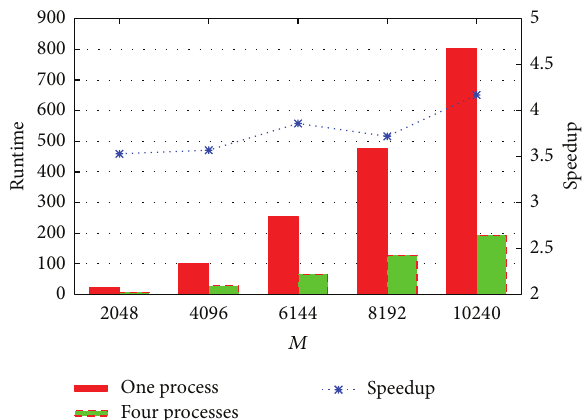
Figure 7: Performance comparison between one process and four processes on E5540 with fixed 𝑁 = 10 .